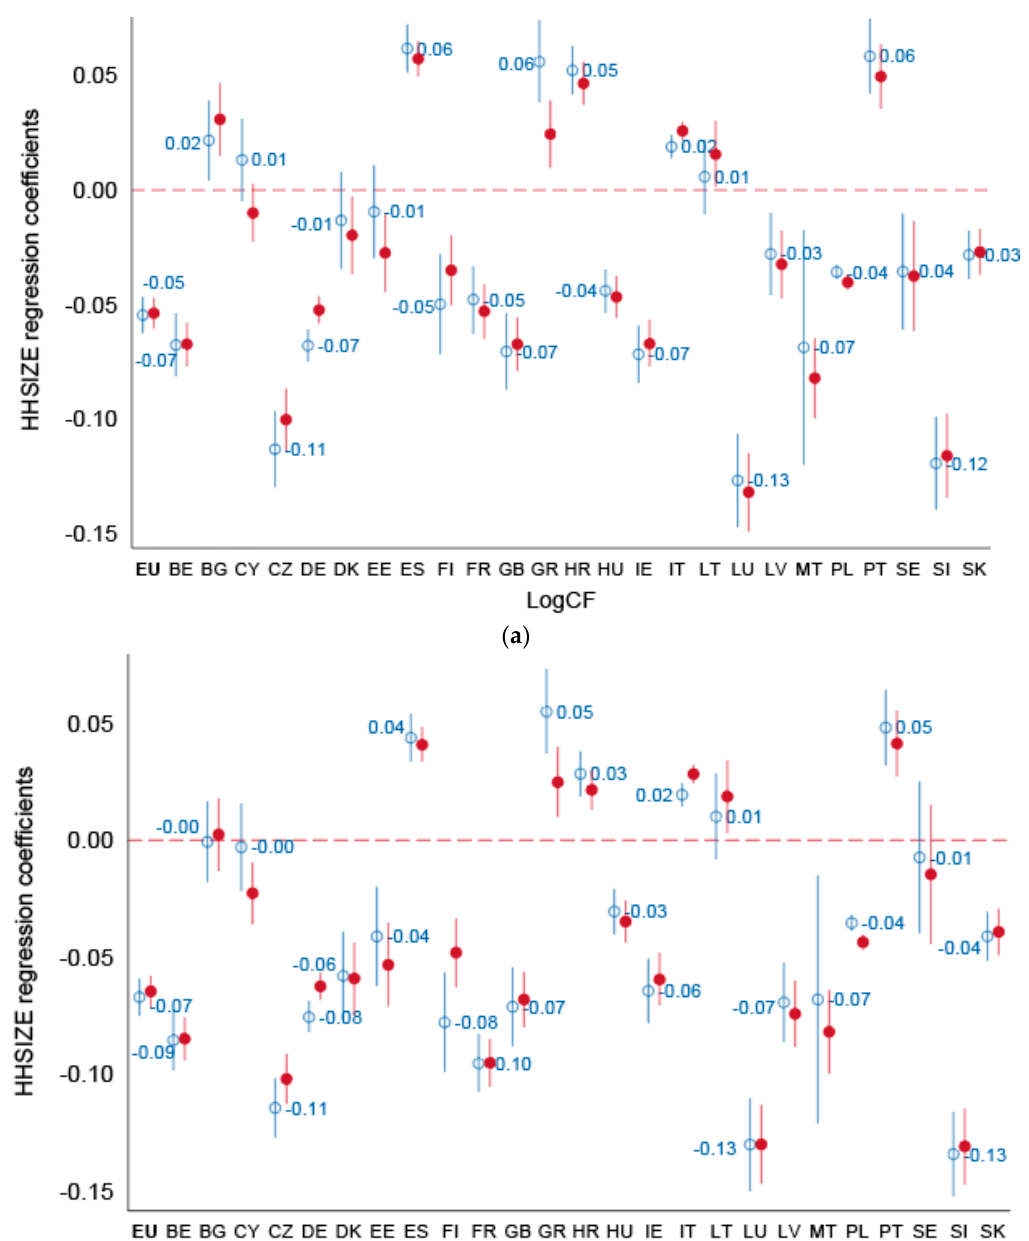
Figure 5. Household size effect across countries with dependent variables—the log of carbon footprints per capita ( a ) and energy footprint per capita ( b ). The blue coefficients depict the HHSIZE coefficient acquired from the model including interaction effect ( HHSIZE×DENSE ) and the red coefficient—the HHSIZE coefficient from the model without any interaction term. All models control for income, rural-urban typology and region. See Data and Methods for the model specification. Household weights provided by the HBS have been applied.